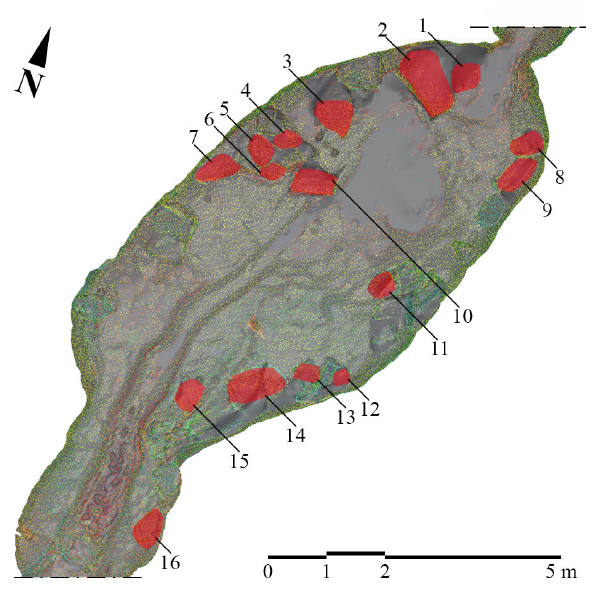
Figure 9 . Top view of the interior main entrance room 3D model with the identification of the 16 blocks of uncertain function and origin.